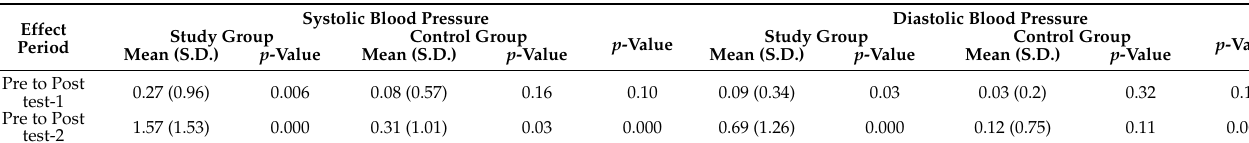
Table 2. Comparison of Effective score for B.P.